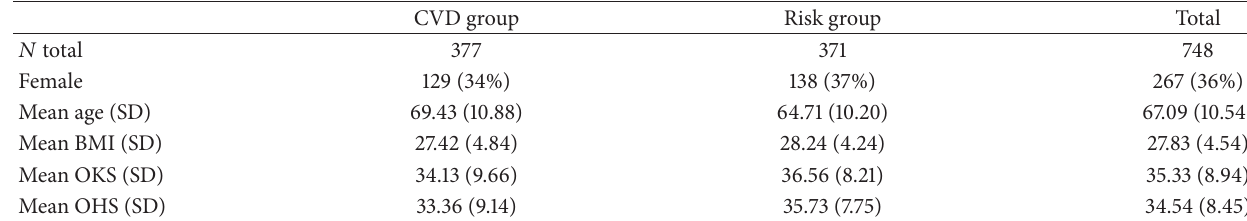
Table 1: Demographic data of the